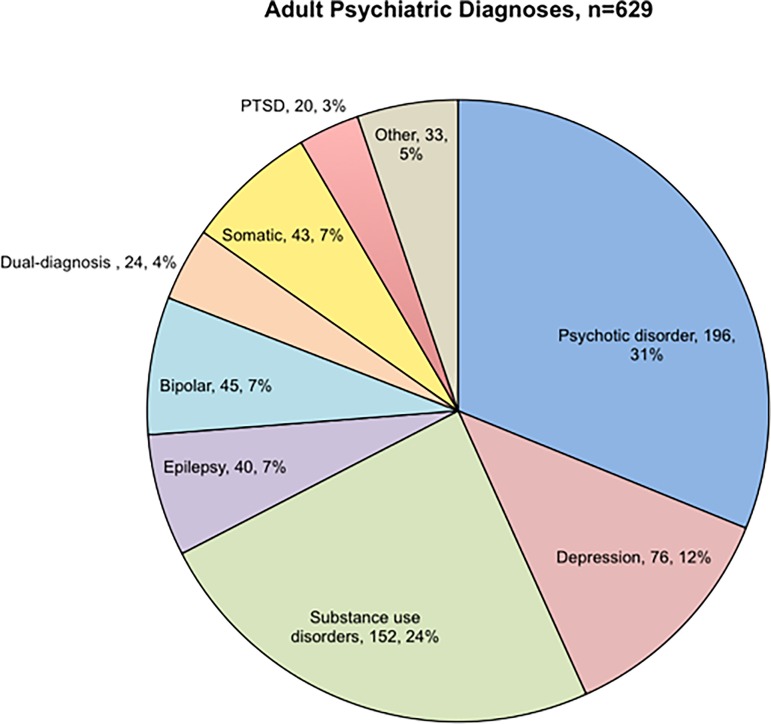
Adult diagnoses (n, %).